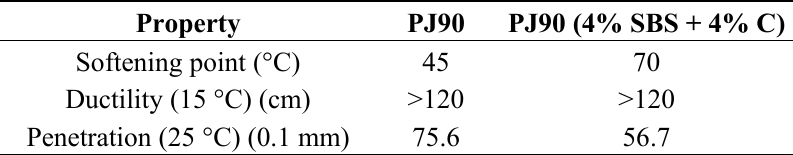
Table 2. The general performance of the evaluated